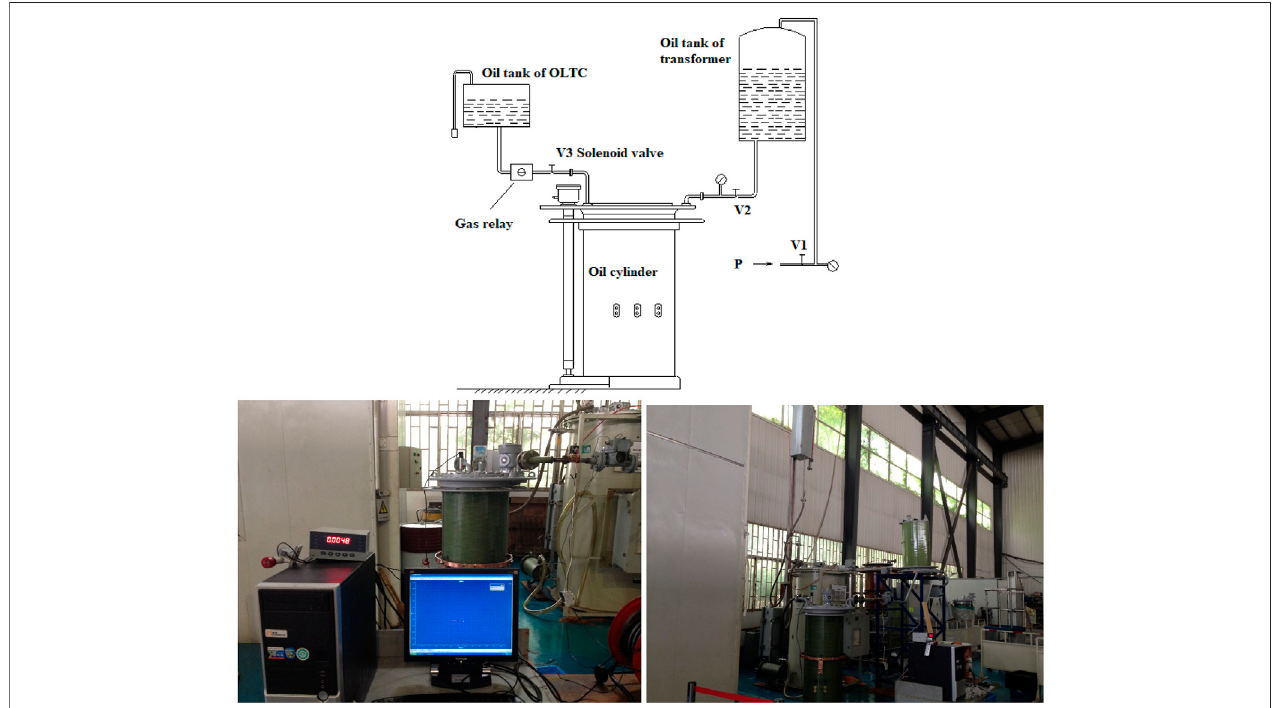
FIGURE 12 | Schematic diagram and physical picture of oil fl ow relay